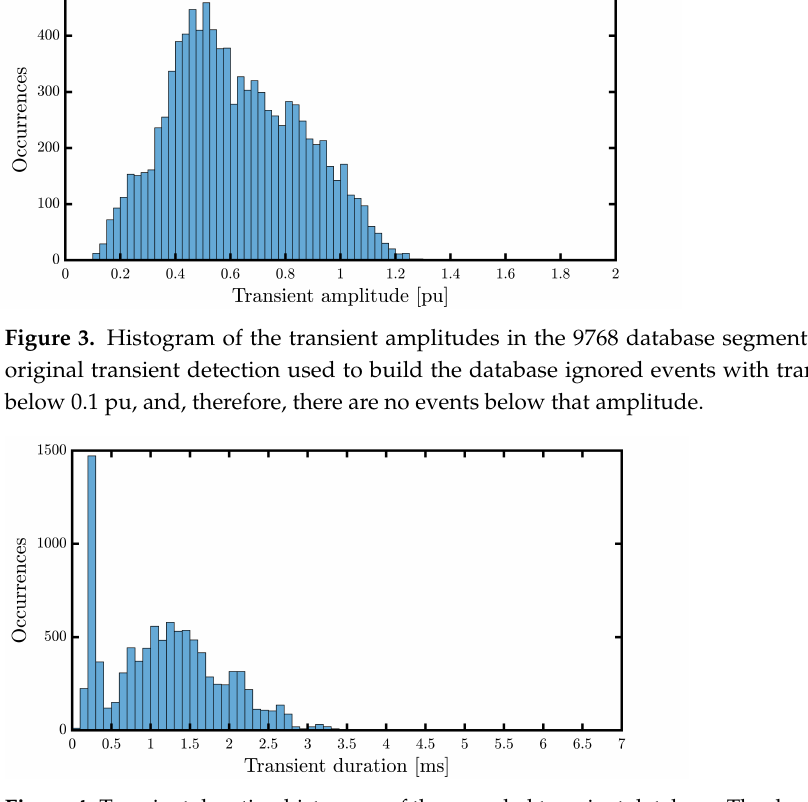
Figure 4. Transient duration histogram of the recorded transient database. The duration was obtained by interpolation of the instances where the closing operation crossed the threshold